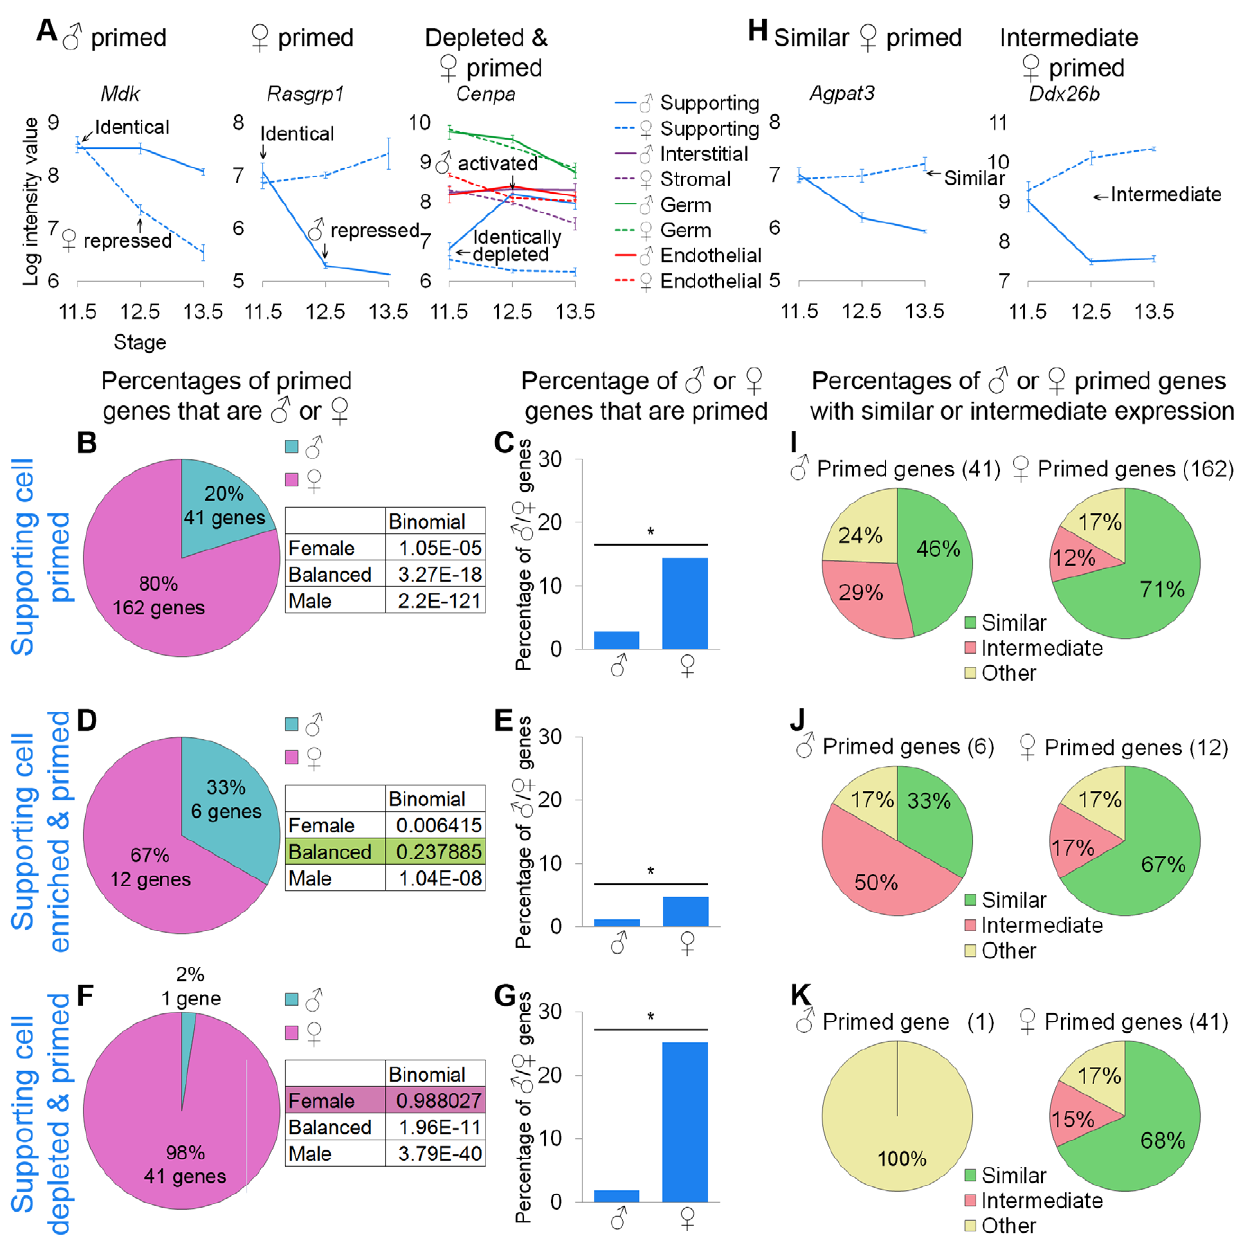
Figure 5. Supporting cells showed lineage priming with a female bias. (A and H) Graphs of the log-transformed, normalized intensity values of genes. The error bars are standard error. Only the values for supporting cells are shown, except in the depleted and primed example where all cell types are shown. (A) Mdk and Rasgrp1 are examples of male- and female-primed genes and Cenpa is an example of a female-primed depleted gene. As in the germ cell analysis, we examined all primed genes (B, C, and I), primed and lineage-specifically enriched genes (D, E, and J), and primed and lineage-specifically depleted genes (F, G, and K). (B, D, and F) The percentages of primed genes that were male-primed and female-primed. The boxes contain the p-values from the binomial test with the expected percentages of the extreme models. (B) Using the first method, all of the extreme models could be excluded because they had a p-value , 0.05. (D and F) However, using the second and third methods, the balanced and female models could not be excluded, respectively. (C, E, and G) Nevertheless, examining the percentage of male or female genes that were primed, all methods showed a significant (*) bias toward the female pathway, as determined by the hypergeometric test (p-value , 0.05). Taken together, the data supported female-biased priming. (H) Graphs illustrating two primed genes, whose expression in the progenitor is ‘‘similar’’ to the differentiated cell of one sex, or ‘‘intermediate’’ between the two sexes. (I–K) The female-primed genes were predominantly similarly expressed, but the male- primed genes showed more variability. Gene lists and permutation tests are provided in Dataset